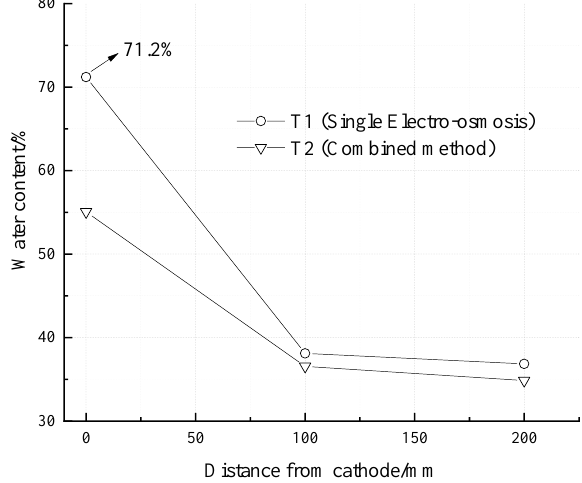
Figure 7. Soil water content distributions of T1 and T2.